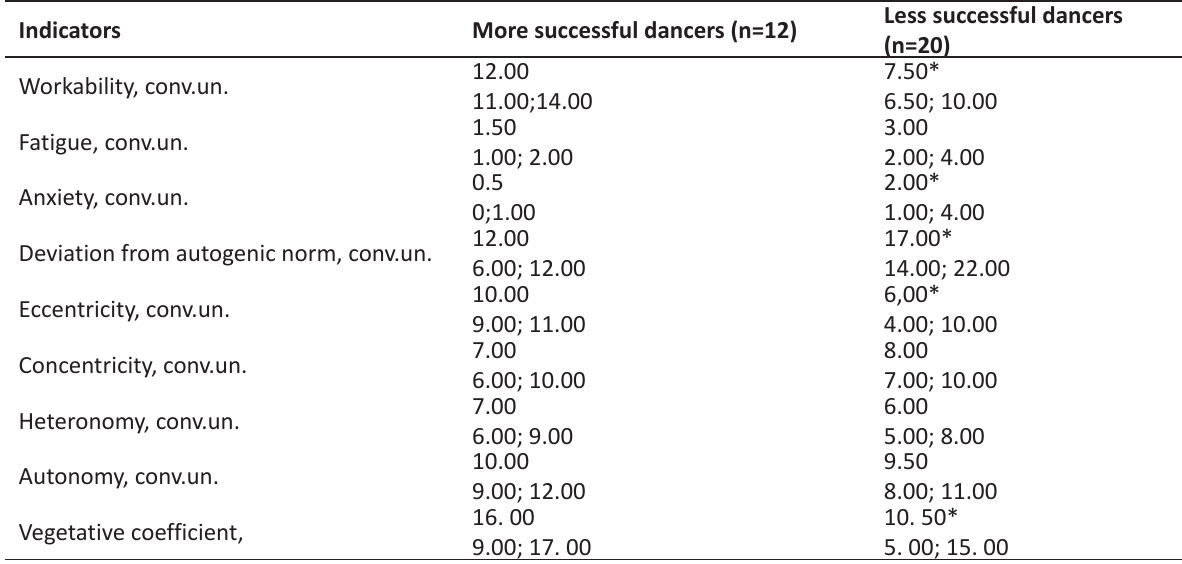
Table 1. Characteristics of psycho-physiological state by Luscher’s test in dancers with different successfulness (median, top and bottom quartiles)